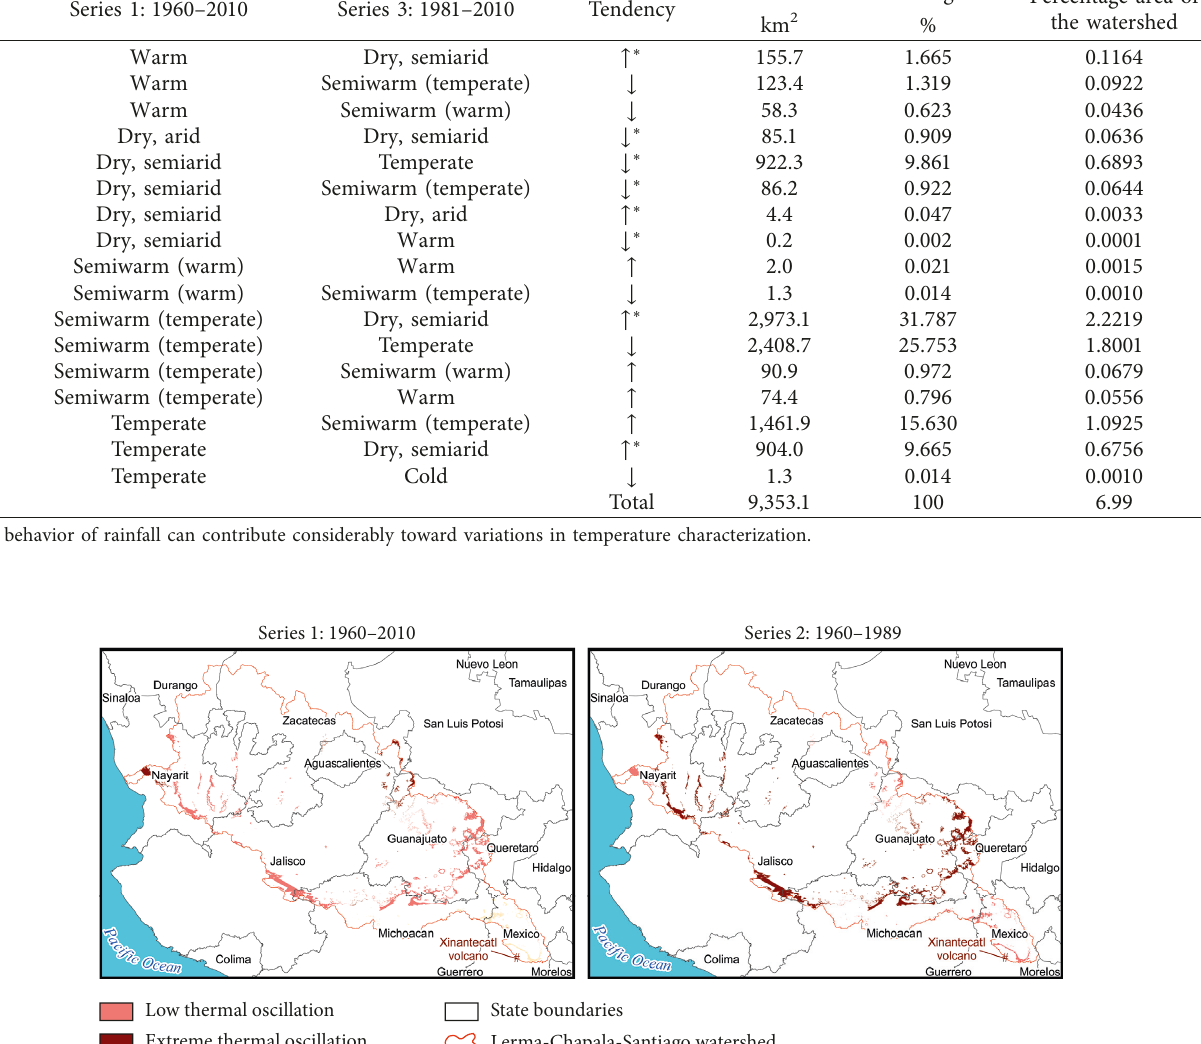
Table 2: Absolute, relative, and proportional areas of the Lerma-Chapala-Santiago watershed with changes in temperature between time series one (1960–2010) and time series three (1981–2010). No.